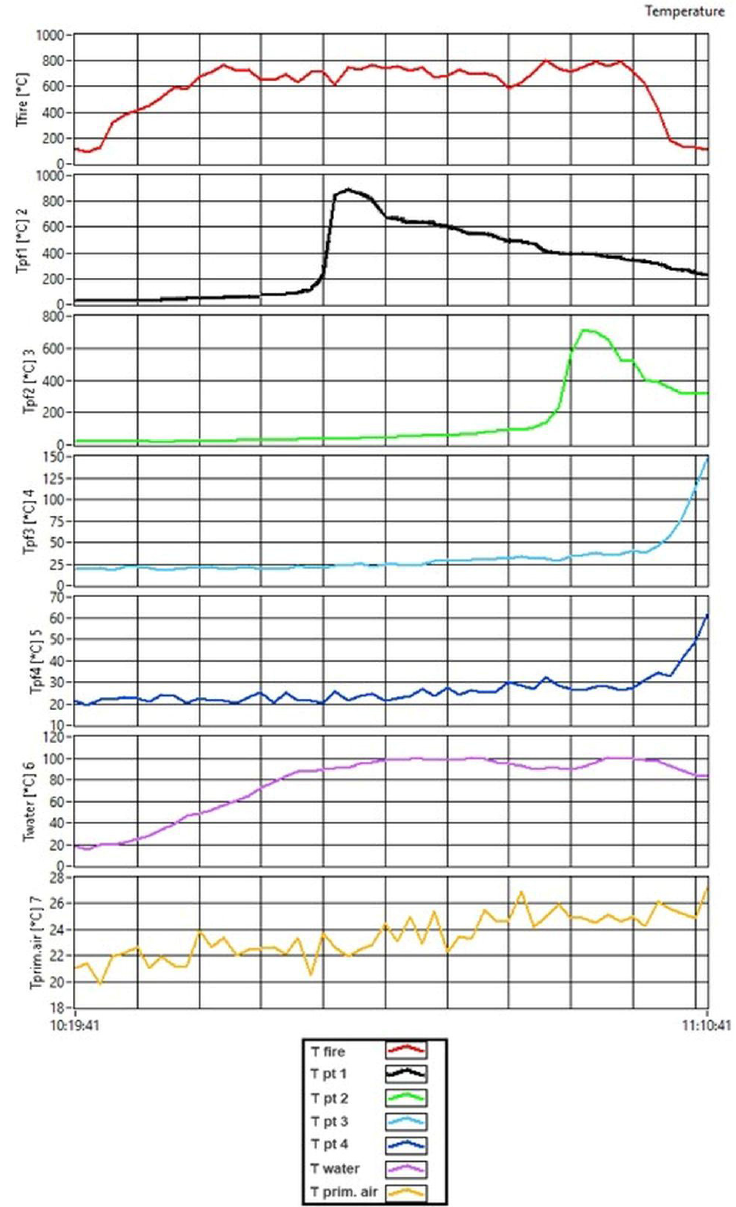
Figure 12. Evolution of temperatures acquired during the test with a ratio of 1/3 and a flow rate of 25/50 L/min.